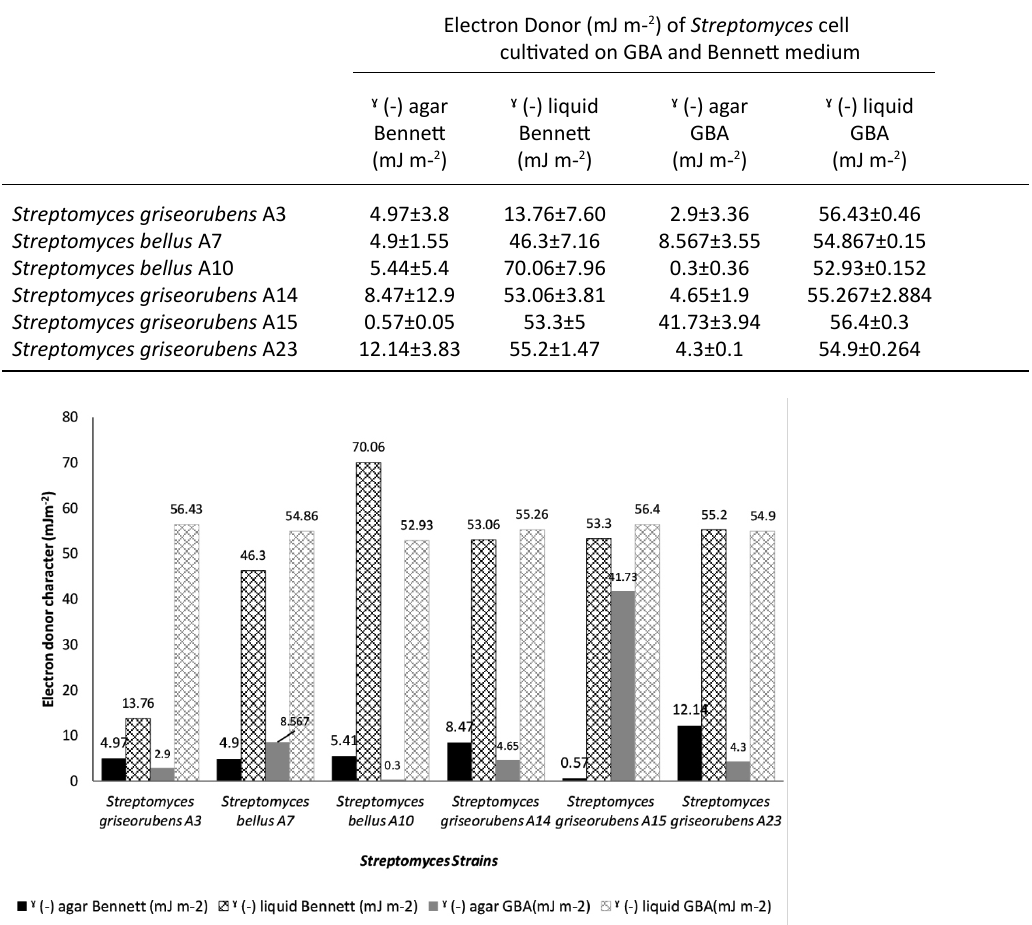
Table 3. Electron donor of Six Streptomyces strains (in mJ m- 2 ),grown in Bennett liquid, agar Bennett, GBA liquid, and agar GBA media